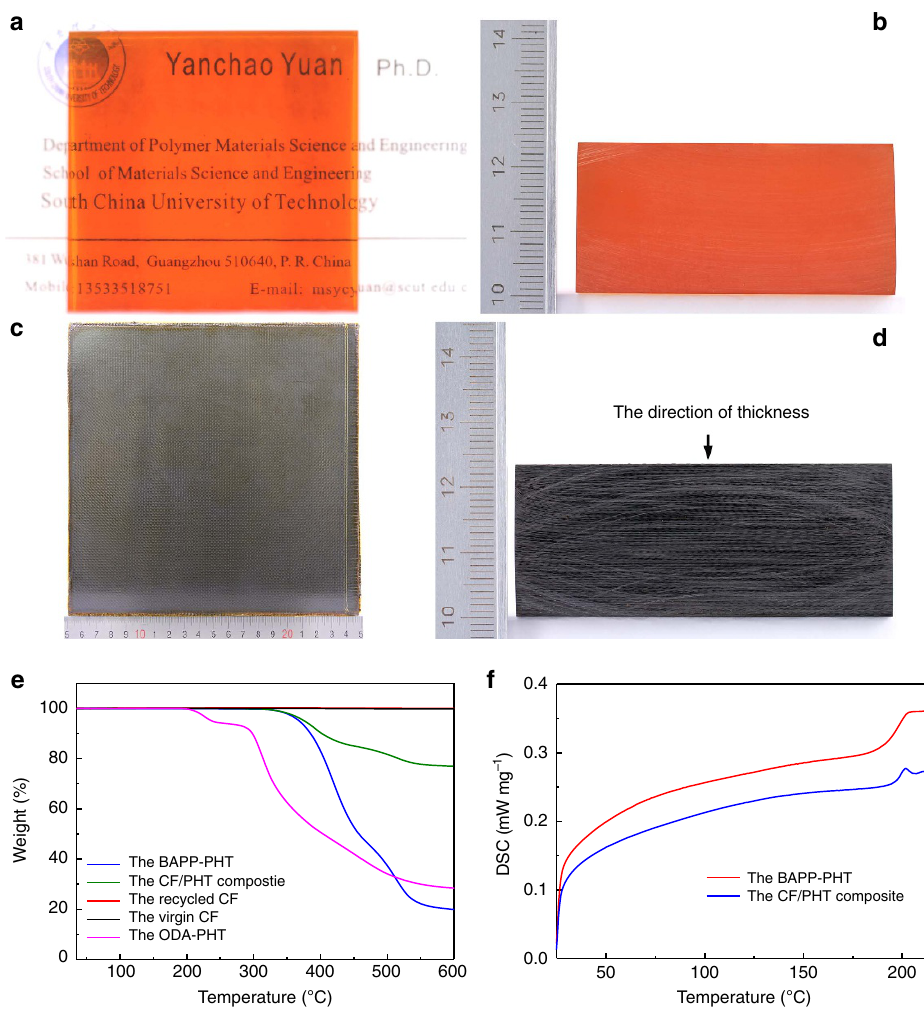
Figure 2 | Apperance and performance of the BAPP-PHT and the CF/PHT composites. ( a ) The BAPP-PHT specimen with a nominal size of 5cm (cid:4) 5cm (cid:4) 24mm (L (cid:4) W (cid:4) H) shows good transparency on a namecard; ( b ) the polished cross section of the BAPP-PHT; ( c ) One representative cross-ply laminate at the nominal size of 20cm (cid:4) 20cm (cid:4) 3mm (L (cid:4) W (cid:4) H); ( d ) One representative cross-ply laminate with the nominal size of 4cm (cid:4) 6cm (cid:4) 23.7mm (L (cid:4) W (cid:4) H) and the cross section been polished with sandpapers; ( e ) TGA curves of the BAPP-PHT, the cross-ply